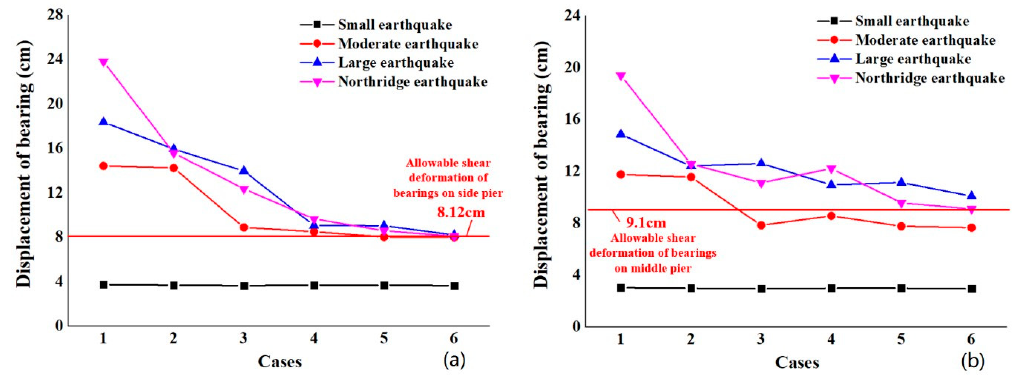
Figure 8. Displacement of bearings in different cases under different earthquakes: ( a ) piers #1 and #5 and ( b ) piers #2, #3, and #4.